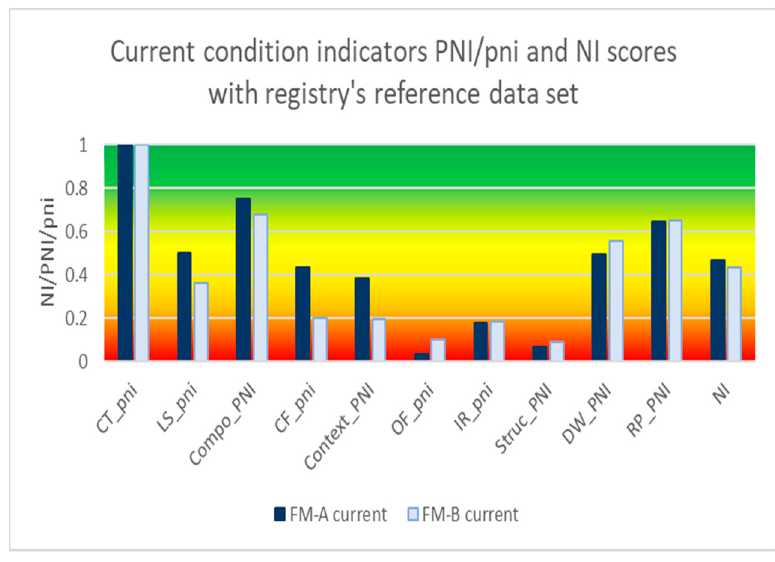
Figure 4. Results for condition indicators and naturalness index (NI) for FM-A and FM-B using registry’s reference state data set [21].